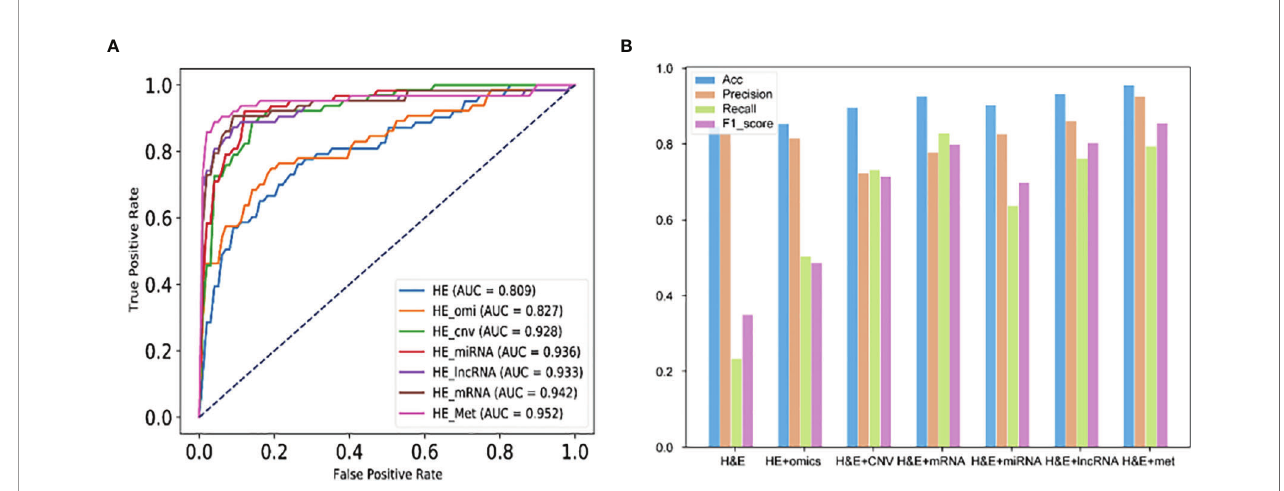
FIGURE 4 | Performance of H&E images and images combined with omics data. (A) The AUC score of image and image combined with omics data. (B) Performance of each mode in Accuracy, Precision, Recall, and F1_score index. HE_omi: H&E image features combined with multi-omics